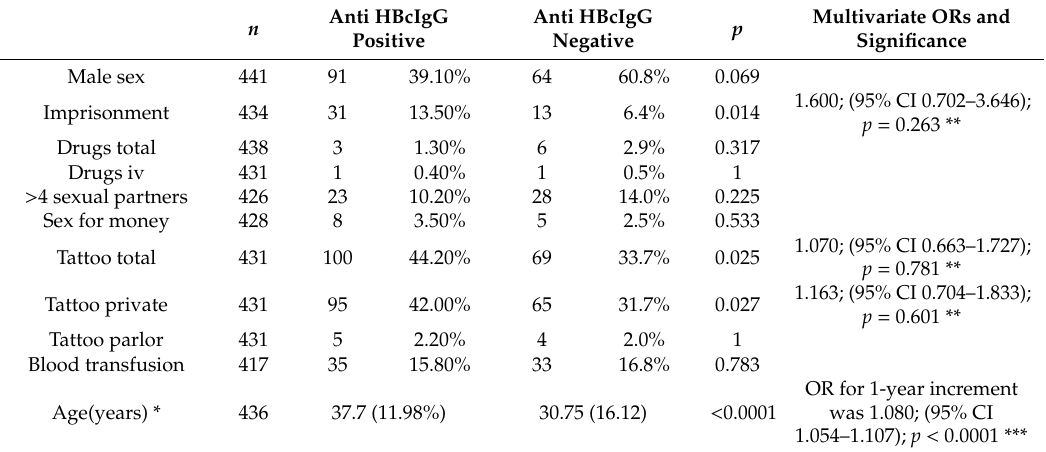
Table 5. A comparison of imprisonment, drug use, blood transfusion, sexual behavior and tattoo procedure between anti HBc IgG-positive and anti HBc IgG-negative Roma people.